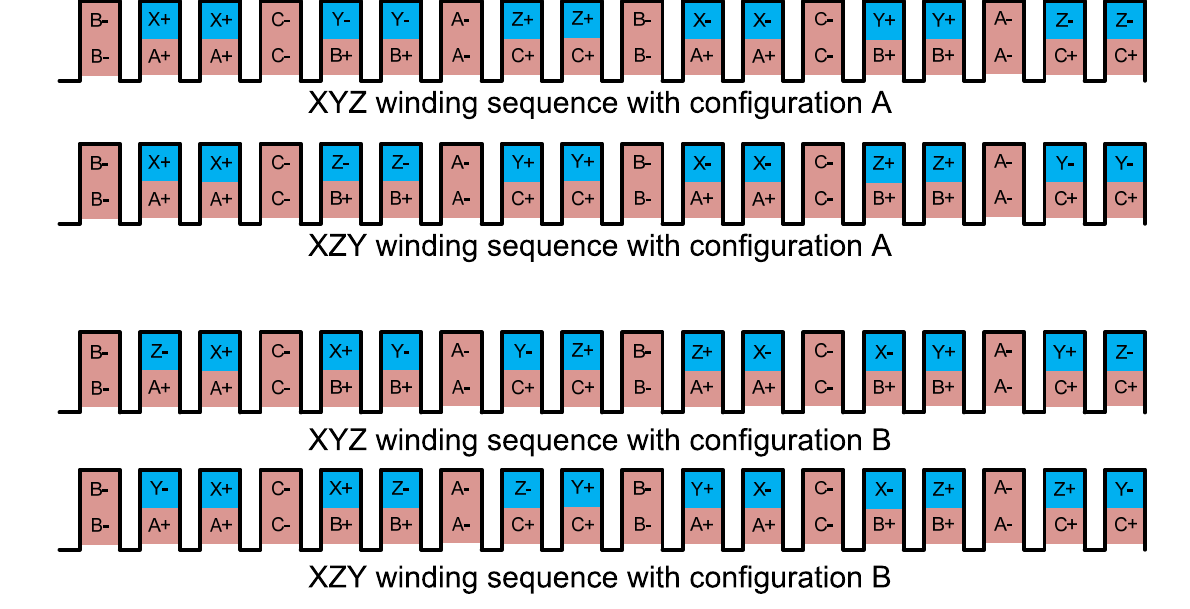
World Electr. Veh. J. 2021 , 12 , 194